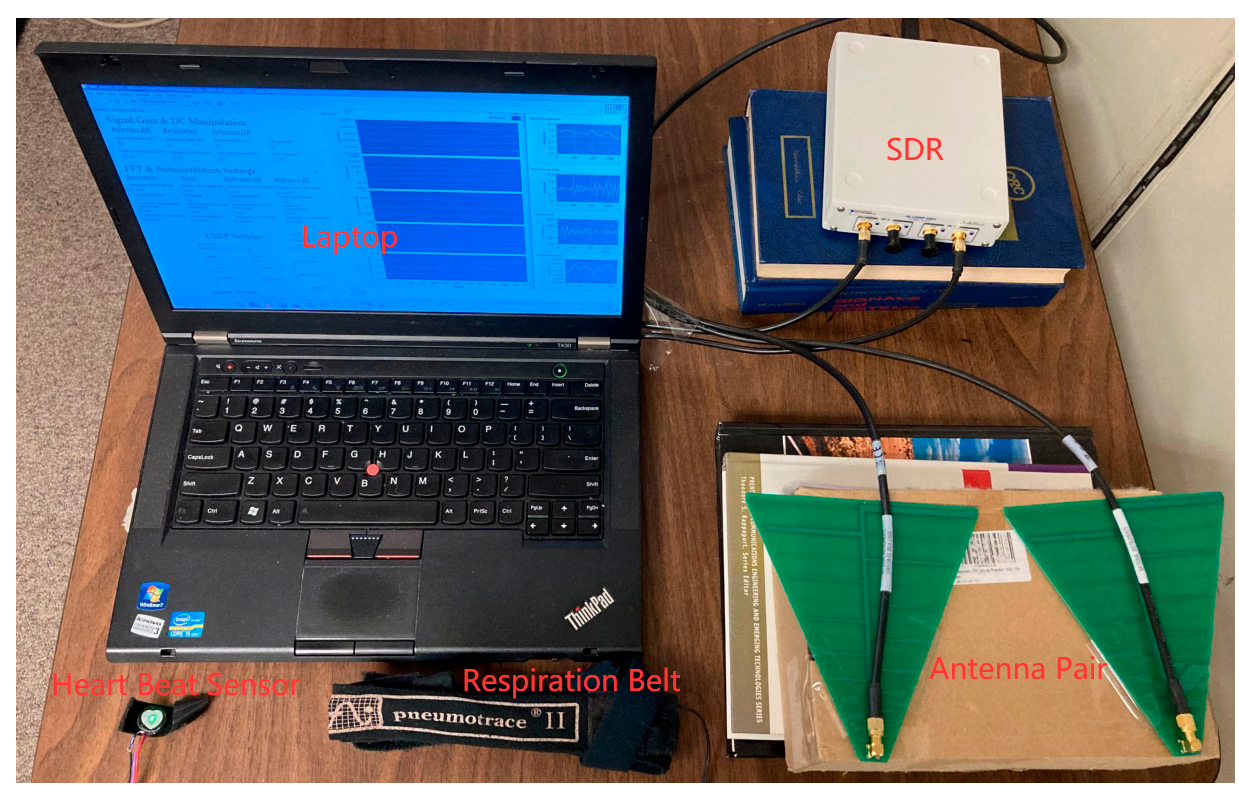
Figure 2. The NCVS hardware components and antennas placement.